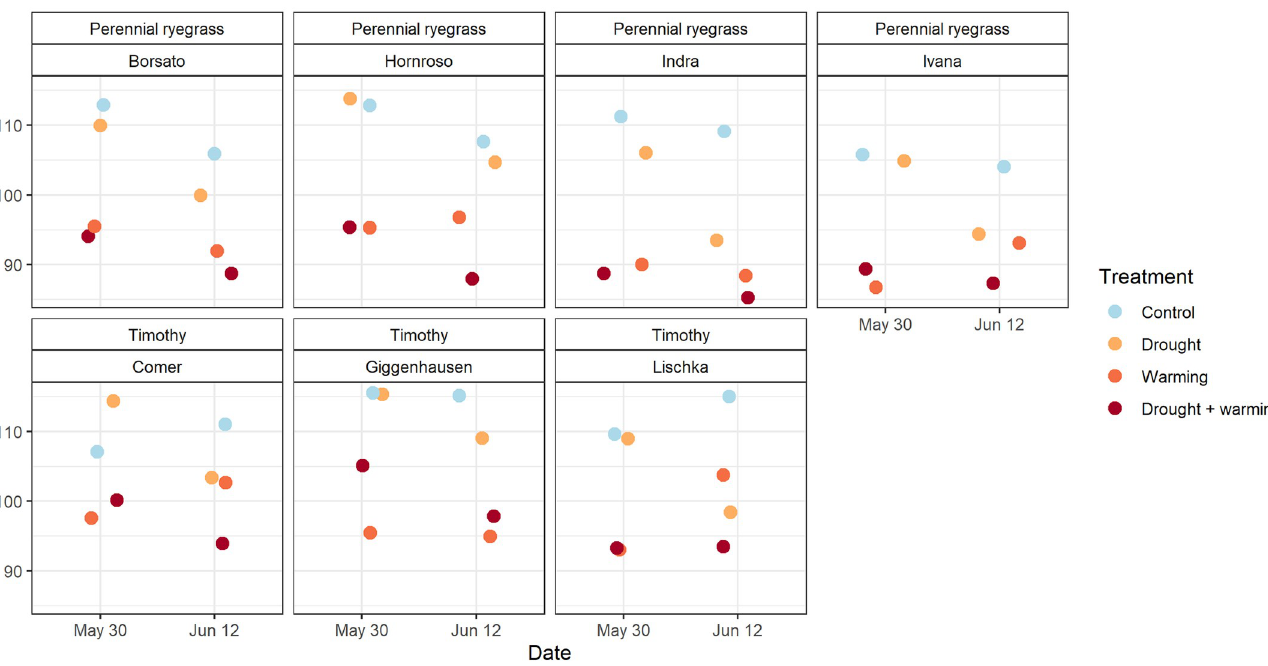
Fig 6. Green values of the cultivars from (a) perennial ryegrass and (b) timothy on May 30 and June 12 2017, the cultivar Classic (timothy) is missing because it was re-included later into the study again.